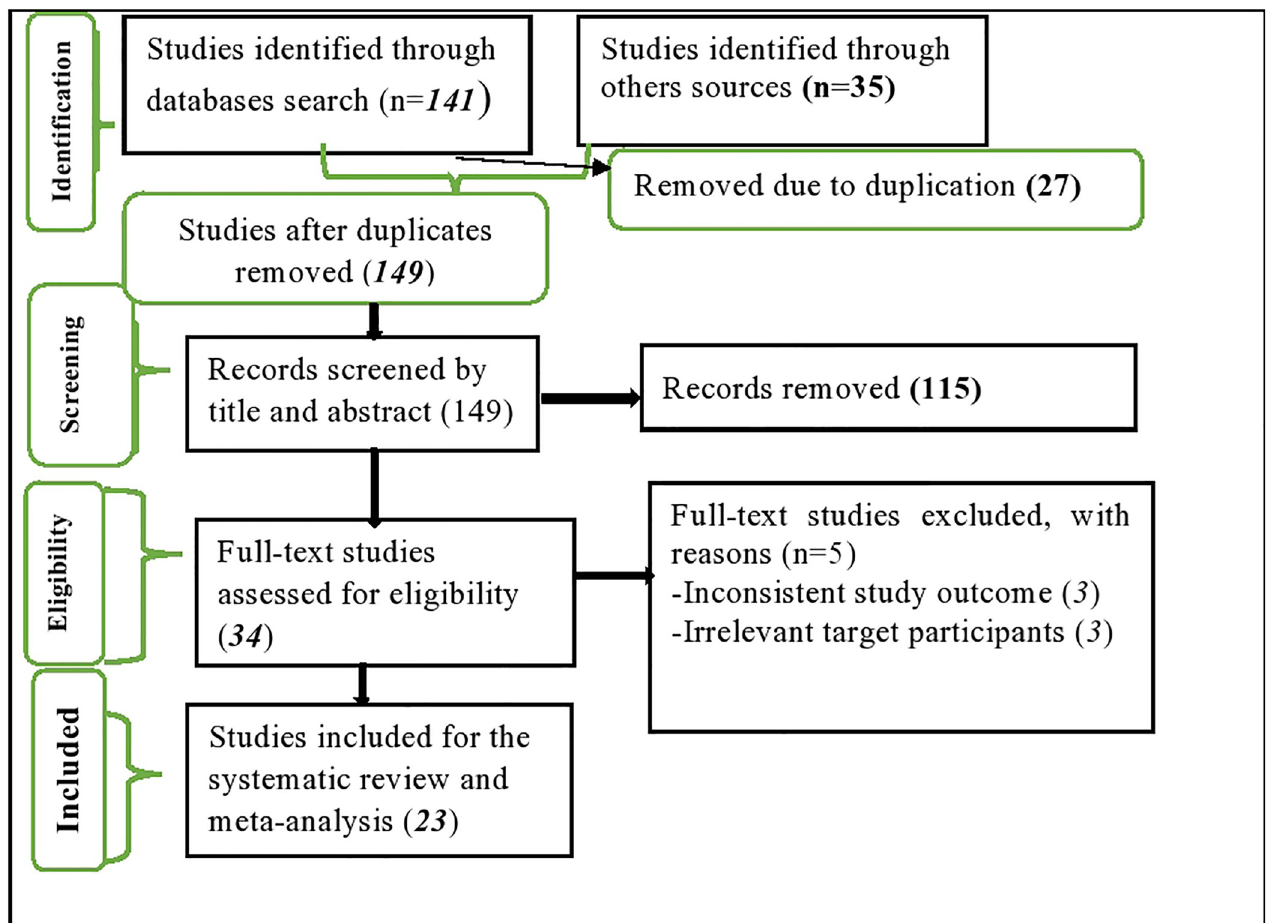
Fig 1. PRISMA flow diagram of the studies included in the